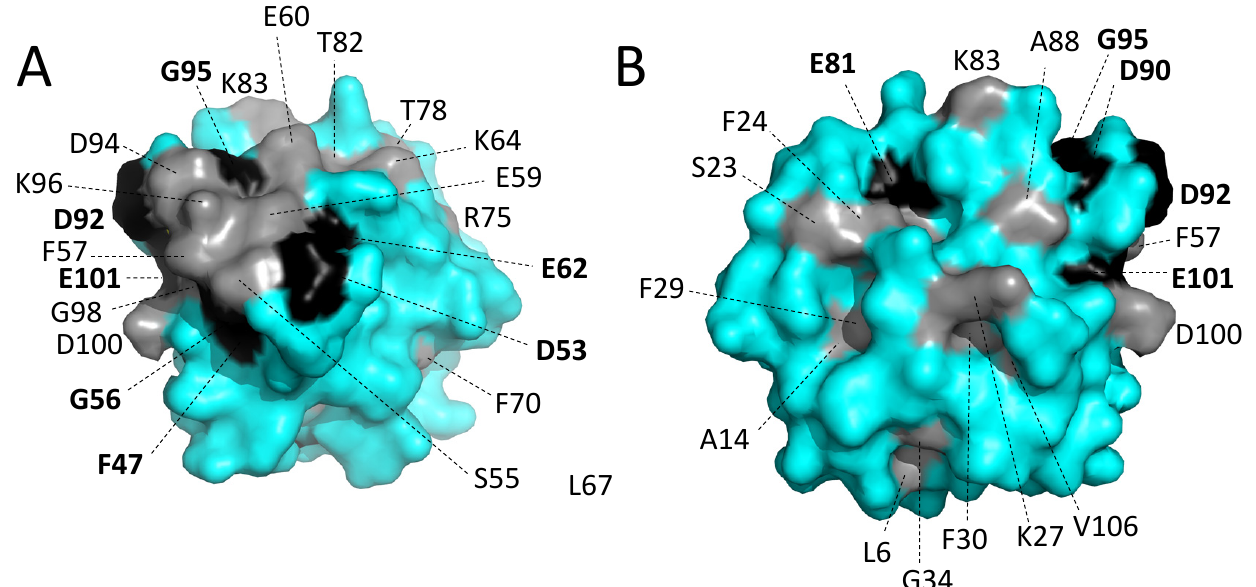
Figure 8. Surface location of residues conserved throughout parvalbumins. The figures ( A , B ) are surface format depictions of common carp pvalb4_(Chr.A3) (4CPV) from different angles. Black and gray coloring refer to conservation among EF-hand domain molecules or more specifically in parvalbumins, respectively (as in Figures 3 and